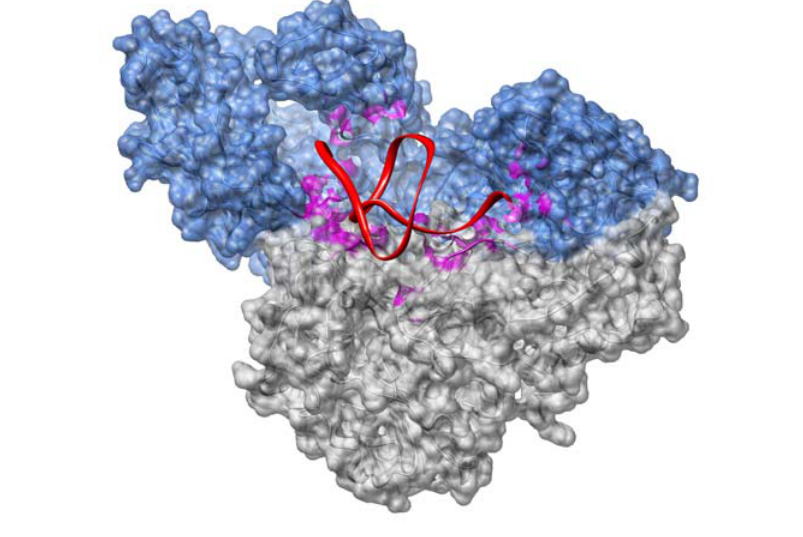
Figure 3. Structure of the HIV-1 RT heterodimer complexed with a 33 nt pseudoknot RNA aptamer (PDB file: 1hvu). The color coding is as follows: p66 (blue), p51 (grey) and RNA (red). Surface residues < 5 Å away from the pseudoknot inhibitor are colored in